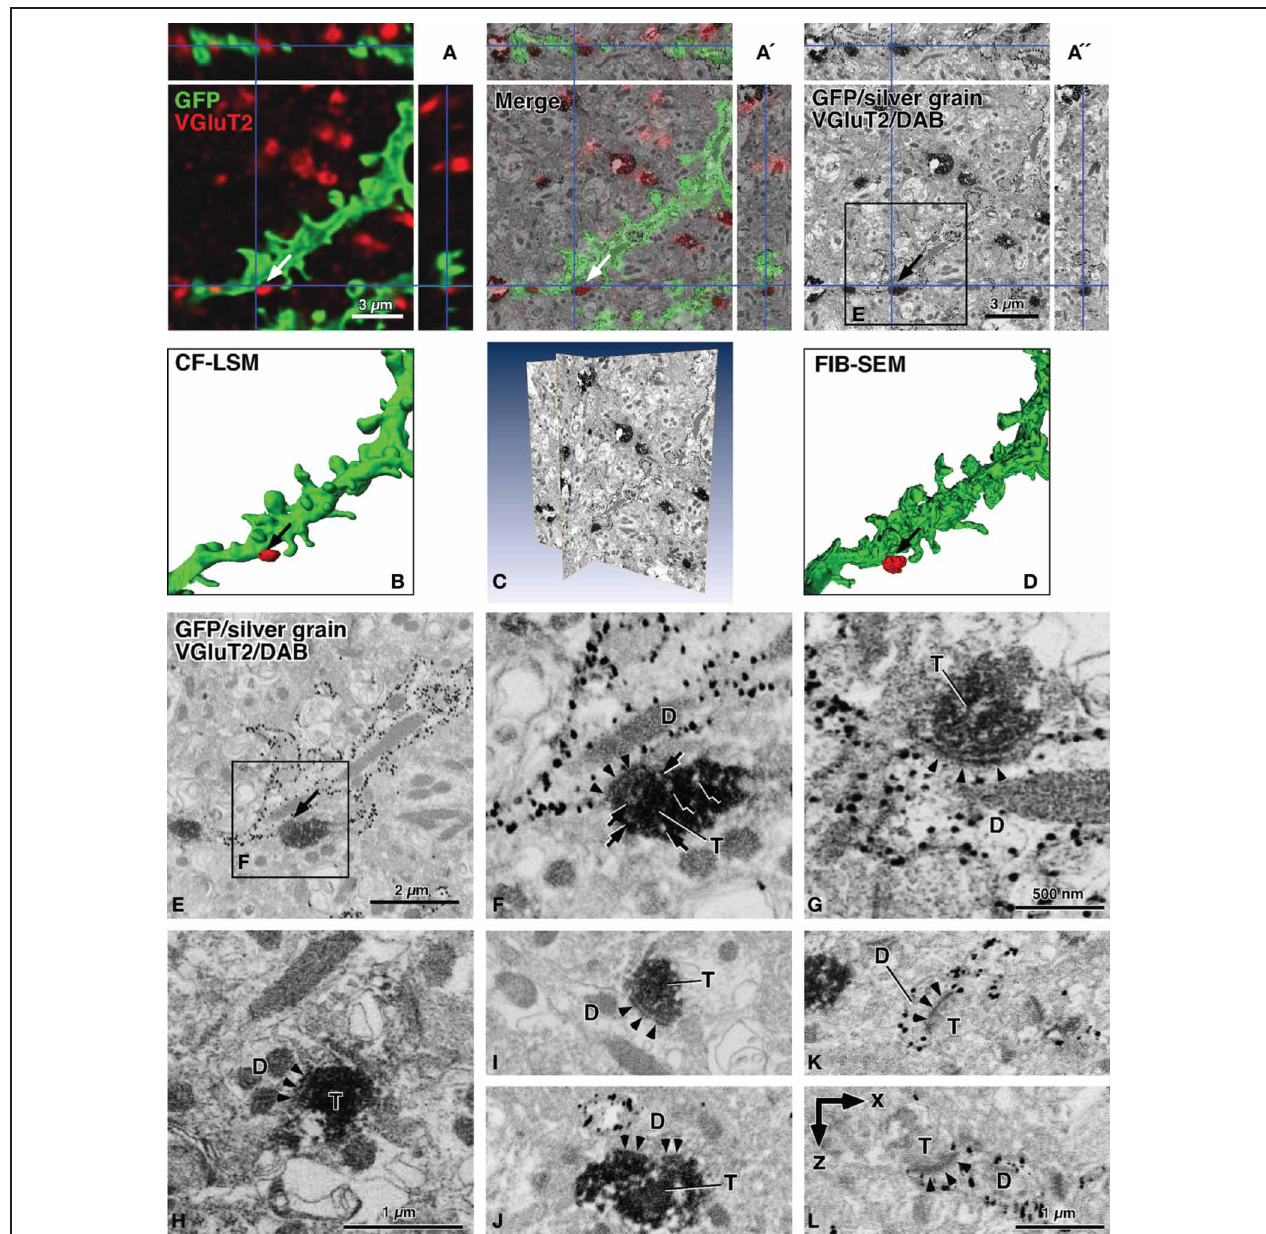
small round organelles with a pale interior, which may represent synaptic vesicles. We found no clear difference in the preservation of the ultrastructures between the long (5min, 300mL) (F,G,I,K,J) vs. short (2min, 100mL) (H) pre-rinse time with PBS before fixative perfusion. Moreover, synaptic contacts were often observed between DAB-positive terminals and unlabeled dendrites (H,I,J) , or between VGluT2-negative terminals and silver-labeled dendrites or dendritic spines (K,L) . The arrowheads in (F–L) indicate postsynaptic densities of asymmetric synapses, and a postsynaptic density was perforated in (J) . Images ( A (cid:2)(cid:2) ,C,E,F, and I ) were obtained using FIB-SEM at 20-nm milling steps. Images ( G,H, and J – L ) were captured using FIB-SEM at 5-nm milling steps, and image (L) was reconstructed in the x – z plane. By the shrinkage factor in electron-microscopic preparation, the size bar in (A) is slightly smaller compared to (A (cid:2)(cid:2) ) . D, dendritic profile; T, axon terminal. Bar in (A) applies to ( A and B ); bar in (A (cid:2)(cid:2) ) to ( A (cid:2)(cid:2) and D ); and bar in (H) to ( F and H ); bar in (L) to (I–L)